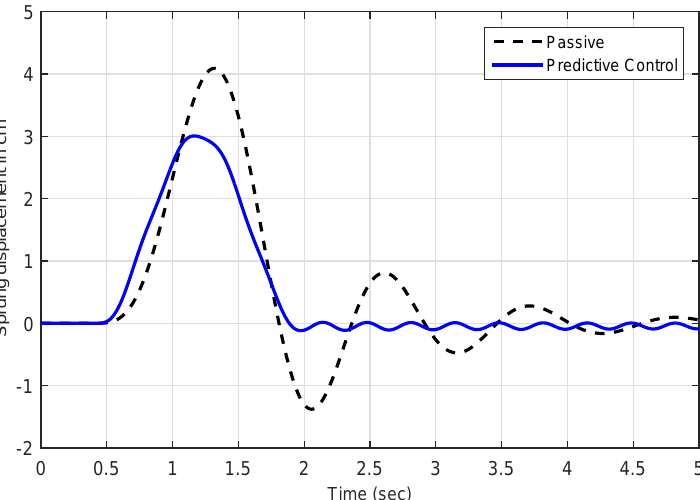
Figure 7. Chassis or sprung mass displacement for the predictive controlled and passive suspensions.